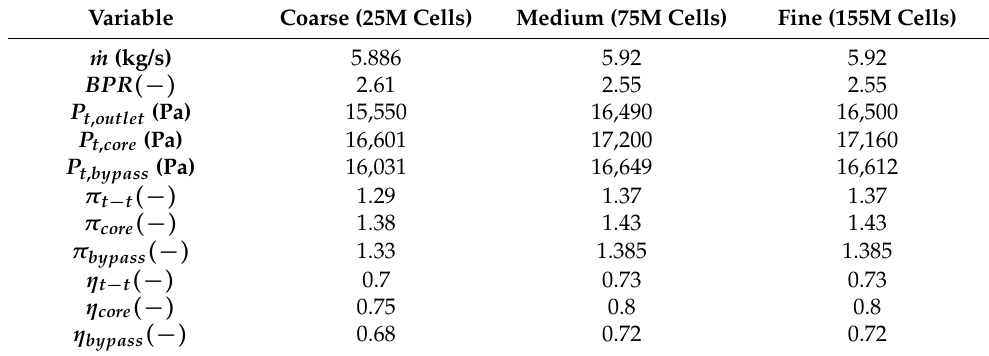
Table 1. Independence of the 3D mesh.